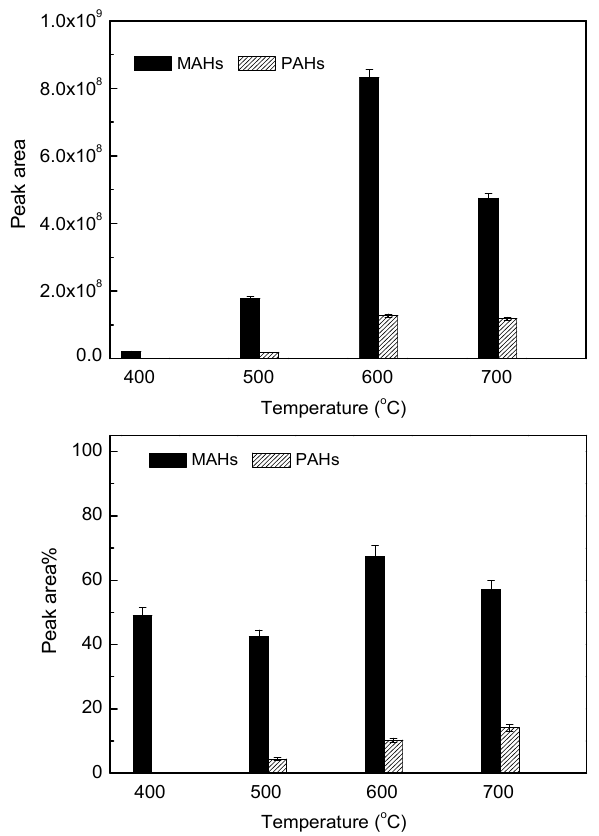
Figure 5. Effects of reaction temperature on the yield and selectivity of aromatics. (10Mo/ZSM-5, catalyst/biomass mass ratio = 10).